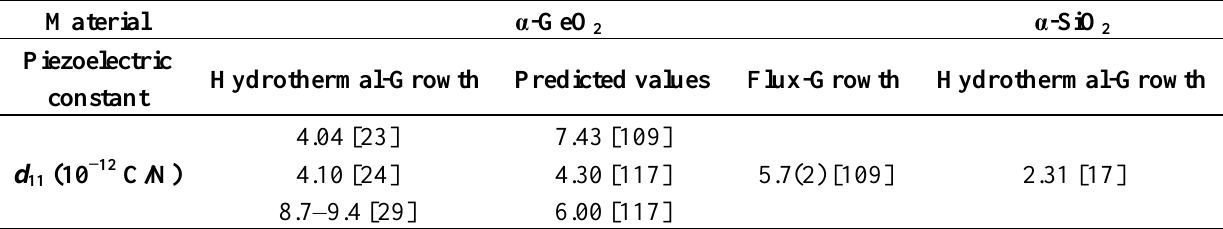
of α-GeO and α-SiO (given for comparison). 11 2 2 2